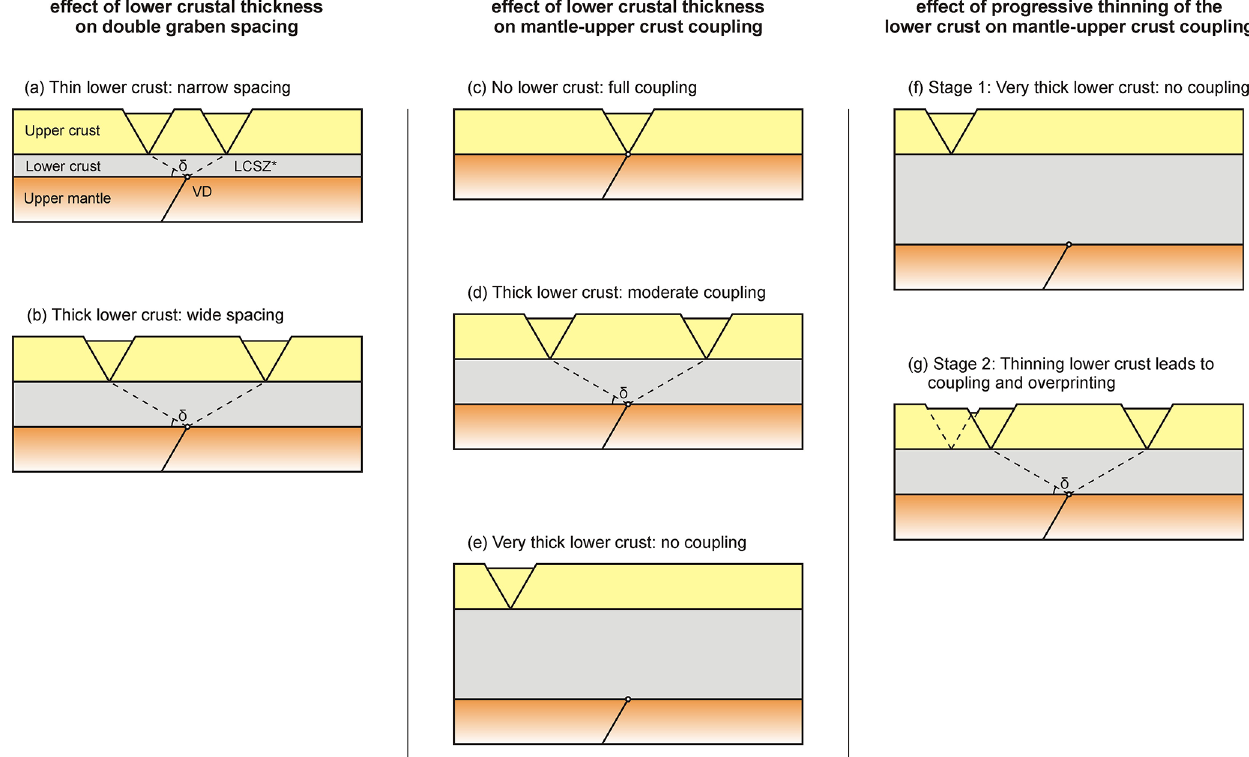
Figure 12. Schematic 2D sketches depicting how lower crustal thickness variations may affect rift structures. (a–b) A thicker lower crust widens the spacing between double grabens related to lower crustal shear zones (LCSZ) originating from a mantle shear zone simulated by a velocity discontinuity (VD) in our models. (c–e) The degree of coupling between the mantle and crust is strongly affected by lower crustal thickness: the thicker the lower the crust, the less coupling occurs. When no coupling occurs, deformation in the upper crust can localize along crustal weaknesses only (e.g. Zwaan et al., 2019). Note, however, that coupling is also affected by extension velocity (e.g. Brun, 1999; Zwaan et al., 2019; see Models J and N, Fig. 11i, k. (f–g) Progressive thinning of the lower crust during rifting may cause a previously decoupled system to become coupled, so that previous upper crustal weakness-controlled structures may be overprinted by mantle-weakness controlled structures. ∗ The LCSZ dip angle ( δ ) is considered to be constant in all